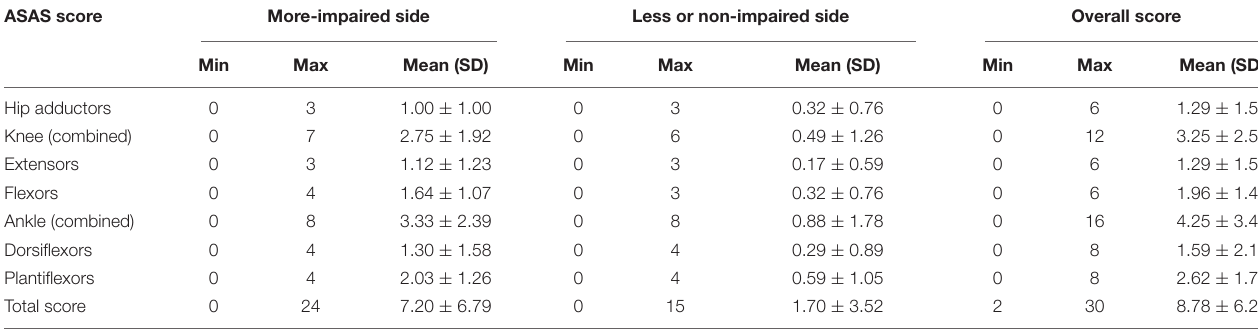
TABLE 1 | Descriptive scores from the Australian Spasticity Assessment Scale (ASAS) in muscle groups and total score by all para-footballers. ASAS score